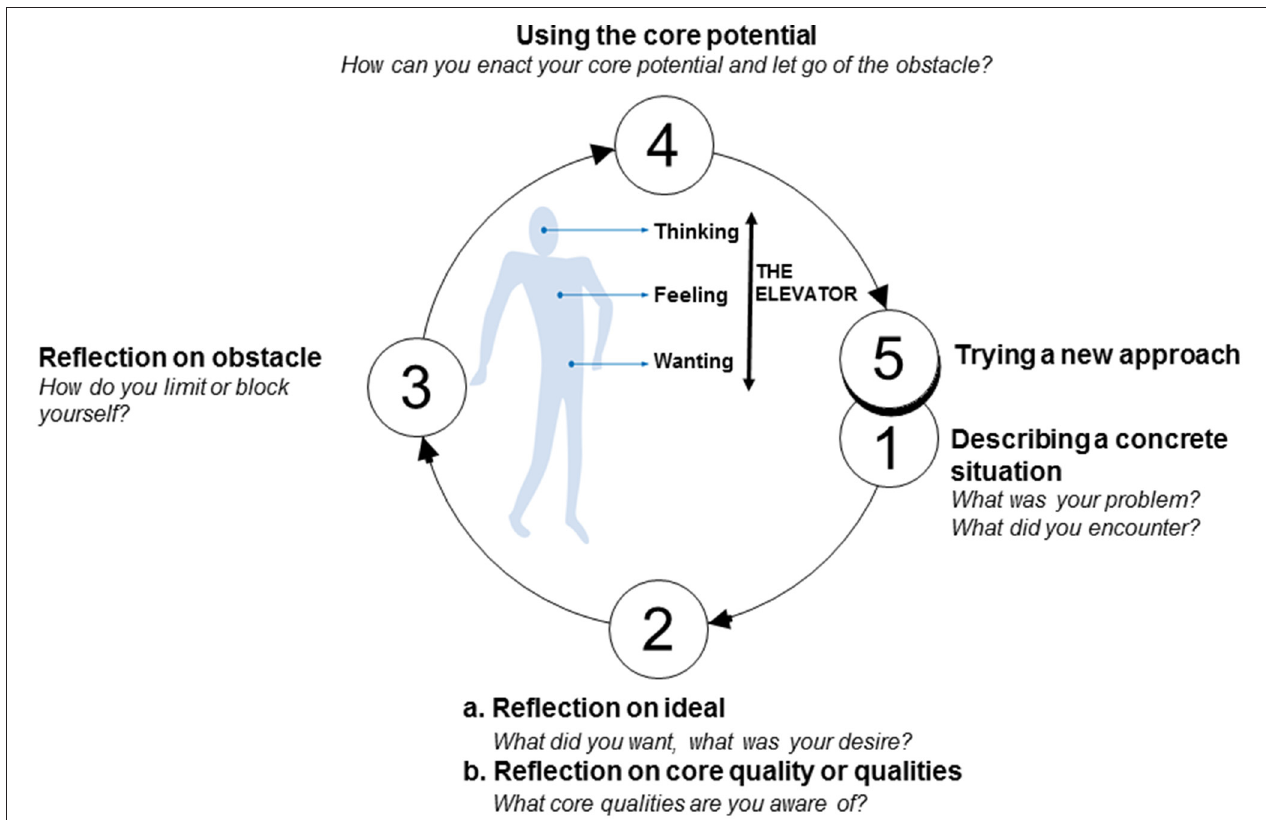
FIGURE 1 | The phase model of core reflection (Korthagen,